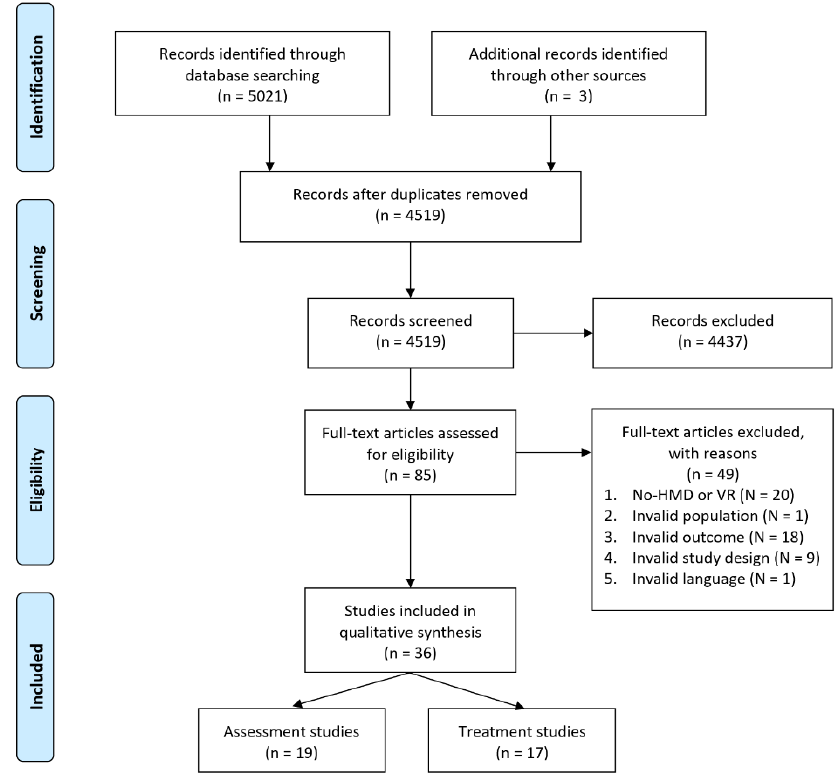
Figure 1. PRISMA flow diagram.